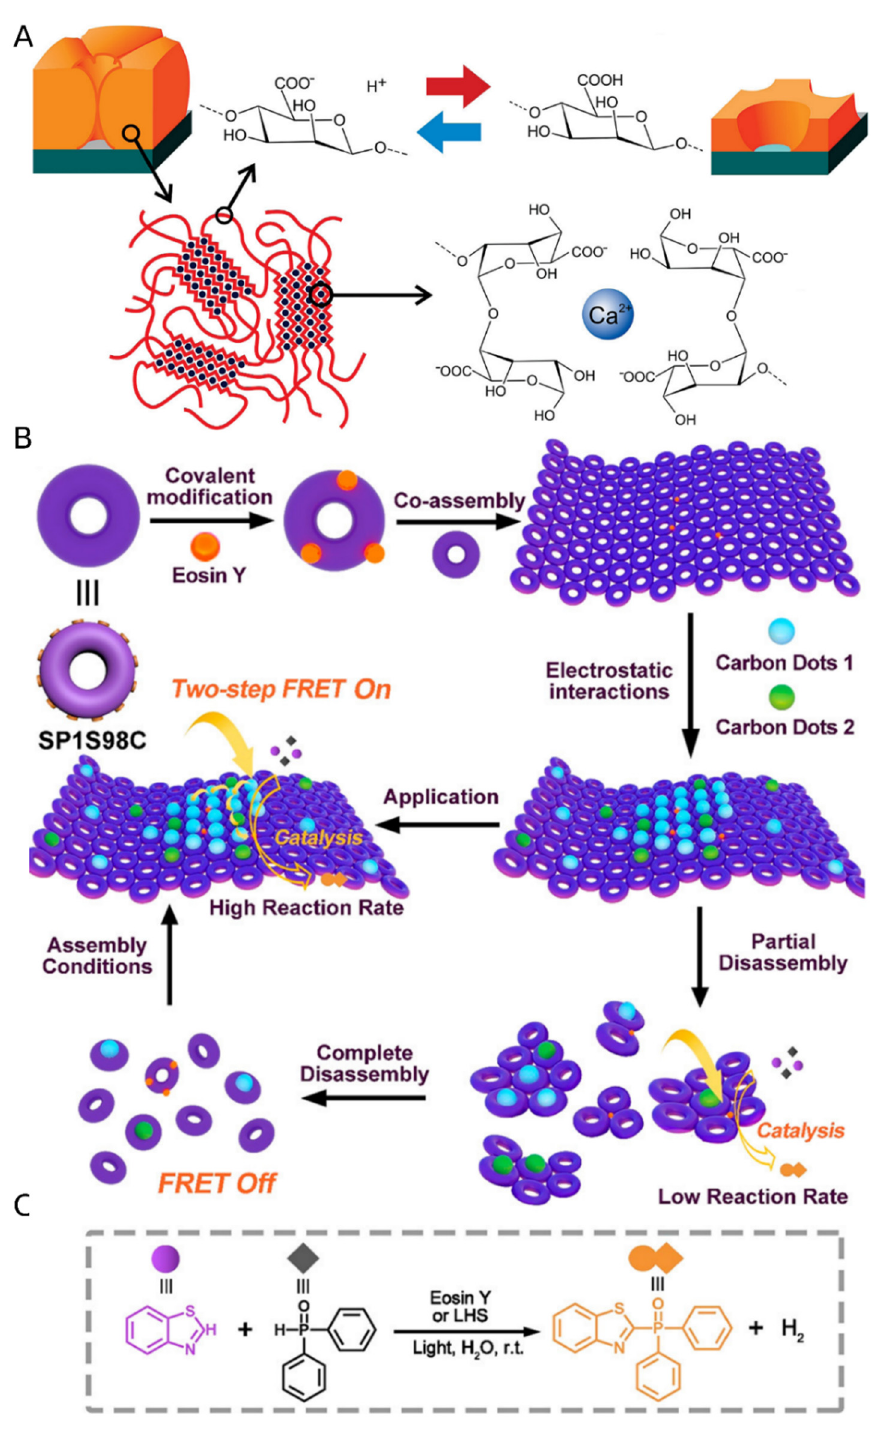
Figure 6. ( A ) Schematic representation of sodium alginate reacting to the change of pH by swelling and consequently becoming less porous. The pores were open when the pH was lower than 4 and closed at pH above 5. Adapted with permission from ref. [264]. Copyright 2009 American Chemical Society. ( B ) Schematic representation of the assembly process of Eosin Y-modified doughnut-shaped proteins into a 2D array. Further modification using quantum dots gives rise to photo-catalytic properties that seize when the 2D structure is disassembled. ( C ) Photocatalytic reaction investigated with the assistance of the 2D on/off system. Panels B and C were adapted with permission from ref. [273]. Copyright 2022 American Chemical Society.